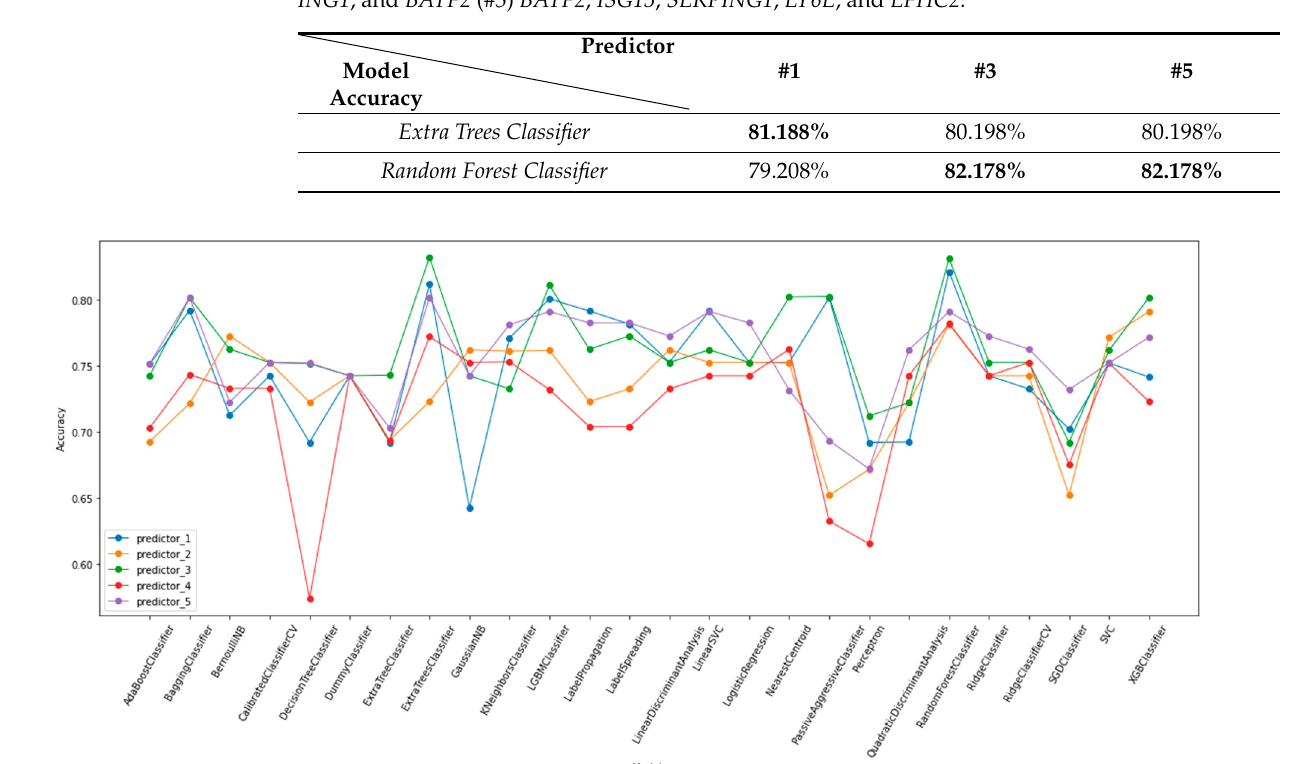
Table 1. Summary of model accuracy results for different gene combinations (predictors), based on RT-qPCR results (2 − ∆ Ct ) : (#1) BATF2, LY6E, MT2A and ISG15 , (#3) MT2A, ISG15, FBXO6, SERP- ING1 , and BATF2 (#5) BATF2 , ISG15 , SERPING1 , LY6E , and EFHC2 .